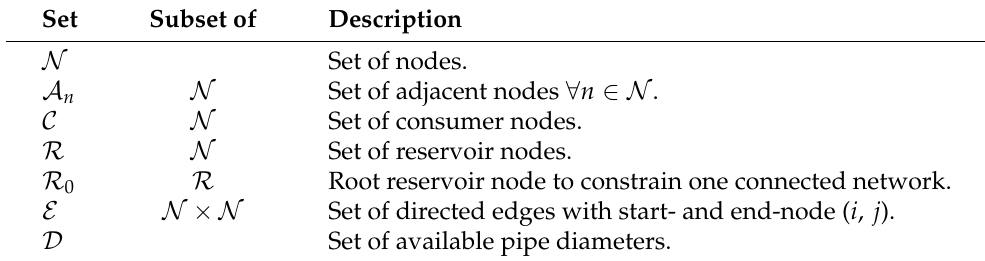
Table 2. Sets of the optimization